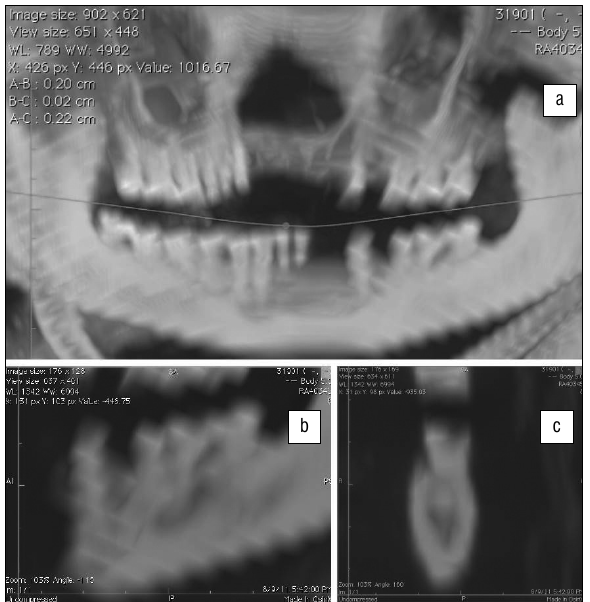
Figure 4: (a) A three-dimensional curved multiplanar reconstruction of the dentition; (b) a two-dimensional multiplanar reconstruction of a sagittal slice of the lower left jaw; and (c) a two- dimensional multiplanar reconstruction of a sagittal slice, with a possible deep carious lesion on the occlusal surface of 36 with apical osteolysis. The vertebral canal was filled with soil and possibly some remains of dura. The dens of the axis was intact but slightly moved forward within the atlanto-axial joint. The disc spaces from L2 to L5 were widened and an anterolisthesis L4 to L5 (10 mm) was seen (post-mortem alterations). Multiple osteophytes could be observed on the lumbar spine (L2–L5; very pronounced at L3 and L4) (Figure 5), mainly at the right frontal side of the vertebral bodies. No further degenerative changes were seen on the vertebral column.